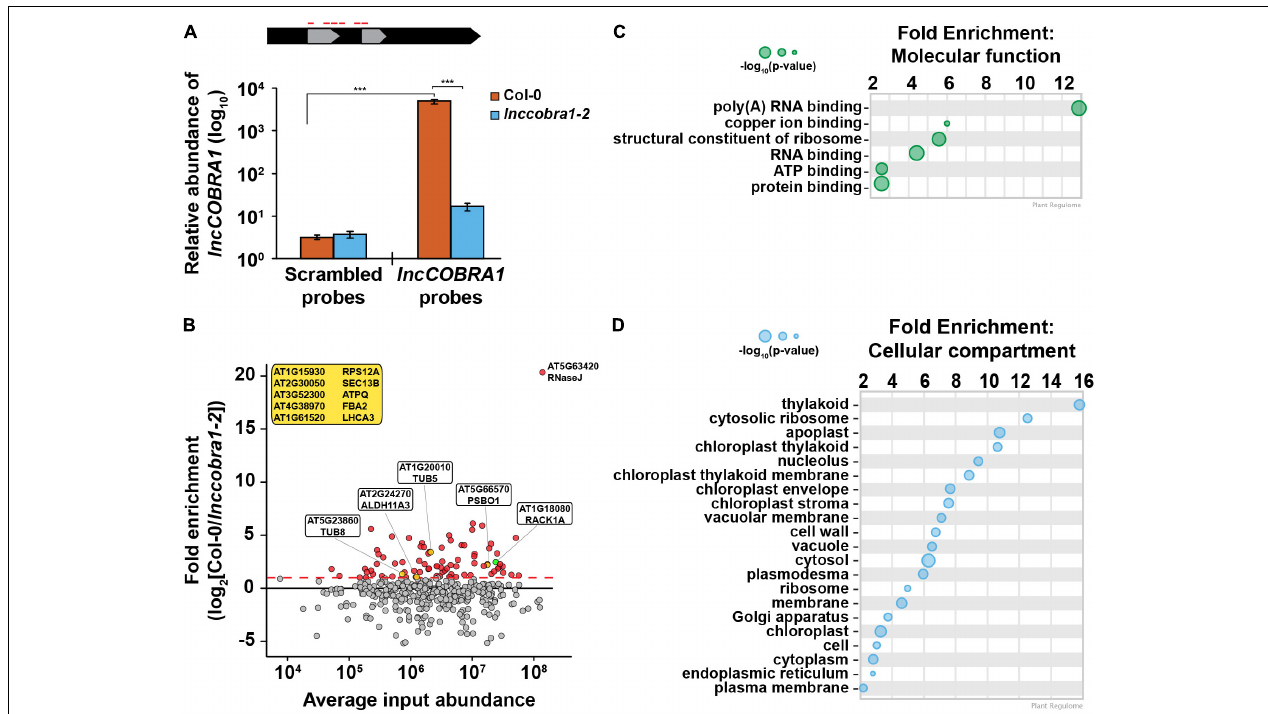
FIGURE 4 | ChIRP enriches for lncCOBRA1 and identifies 113 lncCOBRA1 -interacting proteins. (A) Relative abundance of lncCOBRA1 in ChIRP-MS experiments. Abundance normalized by U6 and is relative to Col-0 input. Error bars represent SEM. ns, *, **, and *** denotes p -value > 0.05, < 0.05, < 0.01, and < 0.001, respectively; Wilcoxon t -test. N = 3. (B) Proteins identified from ChIRP followed by MS. X -axis is the average protein abundance in Col-0 and cobra1-2 inputs. Y -axis is fold enrichment in Col-0 relative to lnccobra1-2 with lncCOBRA1 probes. All dots were enriched with lncCOBRA1 probes compared to scrambled sequence probes. Red dots indicate proteins enriched with lncCOBRA1 probes over scrambled and enriched at least 1-fold change in Col-0 compared to lnccobra1-2 . Green dot represents RACK1A. Yellow dots represent lncCOBRA1 -interacting proteins that were experimentally shown to interact with RACK1A. Yellow box contains lncCOBRA1 -interacting proteins that were experimentally shown to interact with RACK1A but were not identified in Col-0 with scrambled probes. N = 3. (C,D) Gene ontology enrichment analysis for molecular function (C) and cellular compartment (D) using Plant Regulomics (Ran et al., 2020) for lncCOBRA1 -interacting proteins. Size of circles represents –log 10 ( p